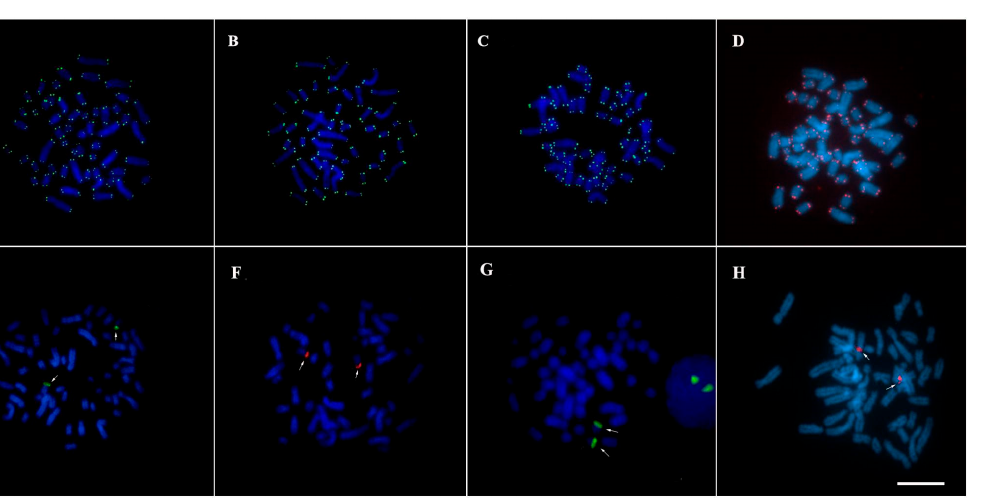
Figure 6. FISH with probe of U2-snDNA ( A , B ) and H3 Histone ( C – F ) genes; ( A – C ) T. m. manatus ; ( B – D ) T. inunguis ; ( E ) “Poque”; and ( F ) “Vitor”. Bar 10 μ m.